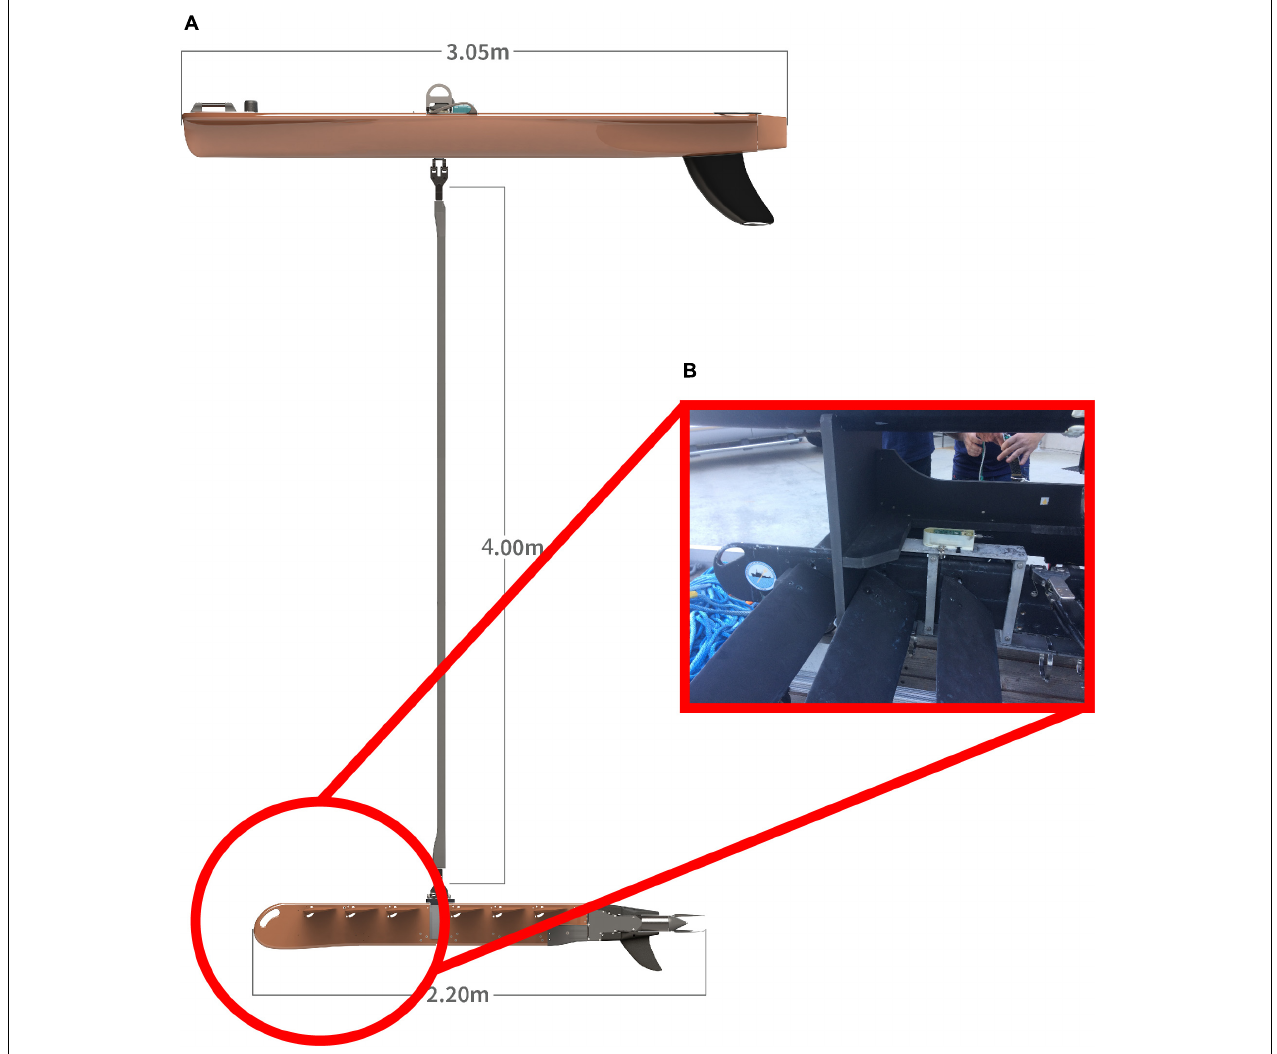
FIGURE 1 | (A) Model of the Wave Glider. (Image courtesy of Liquid Robotics). (B) Location of the Remora-ST underwater acoustic recorder on the